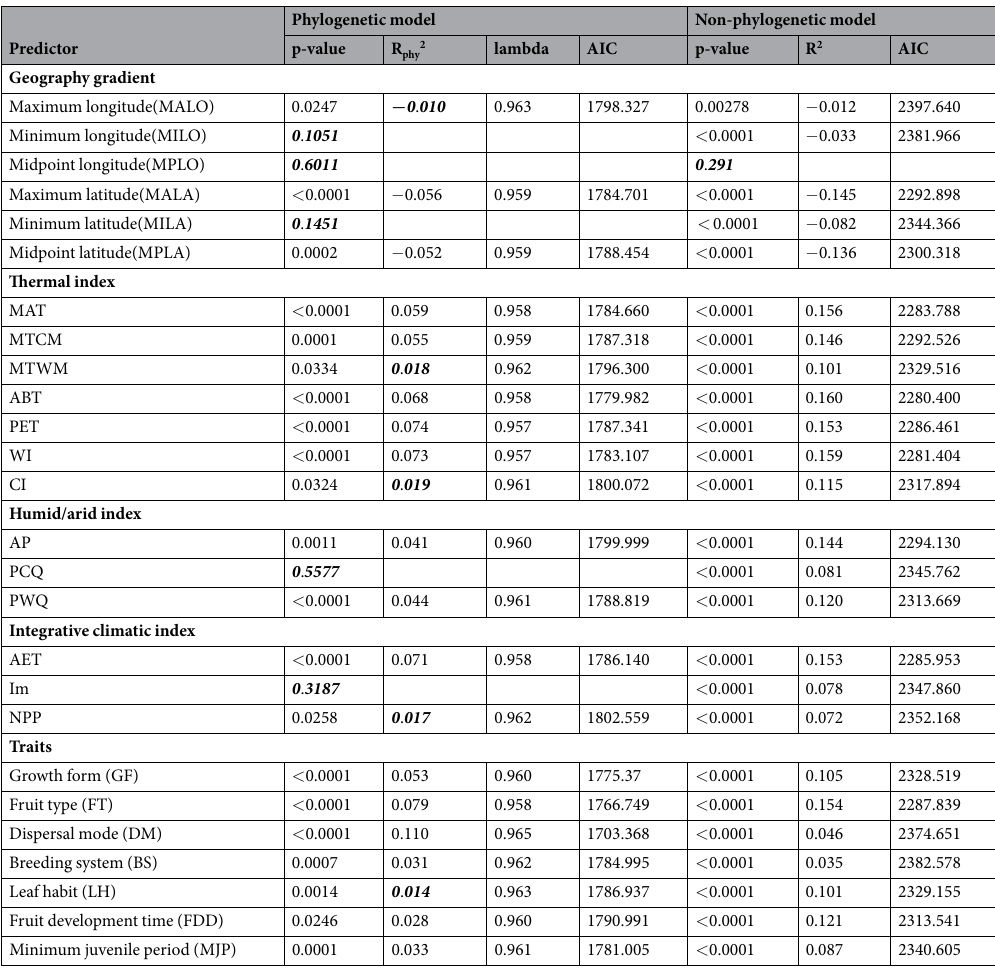
Table 2. Summary of univariate models for explaining seed mass with geographic, climate factors and other traits. Variables in bold italic fond were those with p > 0.05 or R phy2 < 0.02. In the R 2 column, “ − ” denotes negative relationships while others were positive ones. This analysis is conducted with 725 species that have all the variables listed